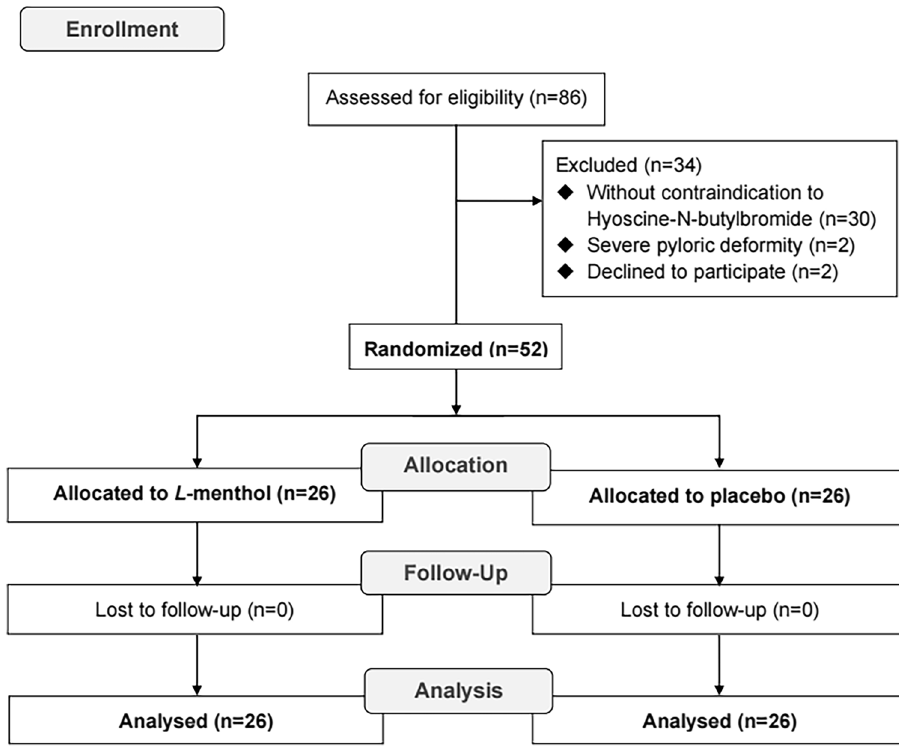
Figure 3. The Consolidated Standards of Reporting Trials (CONSORT) flow diagram of the study.